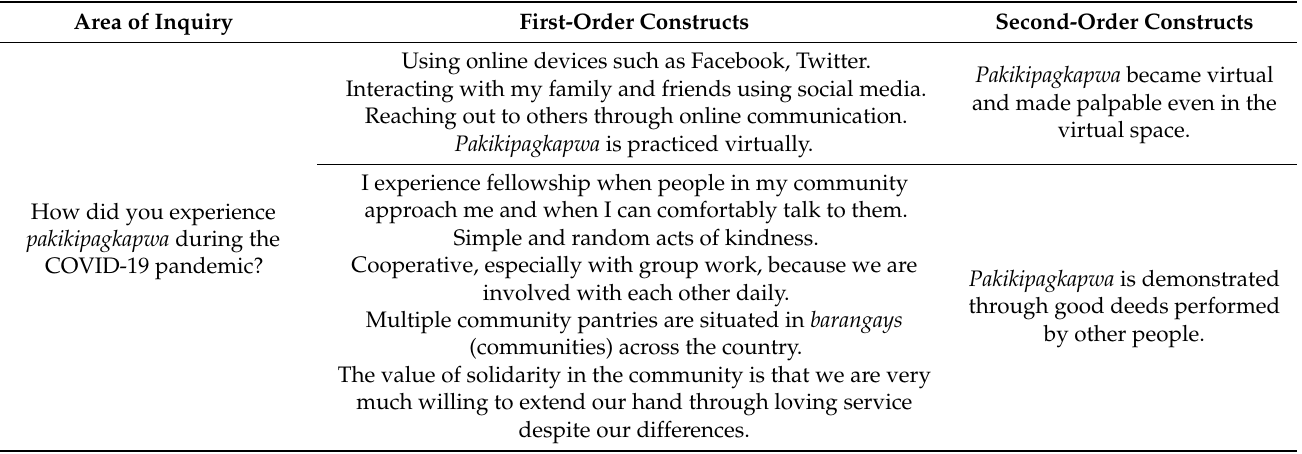
Table 3. Experiences of select Filipino Christians of pakikipagkapwa during the COVID-19